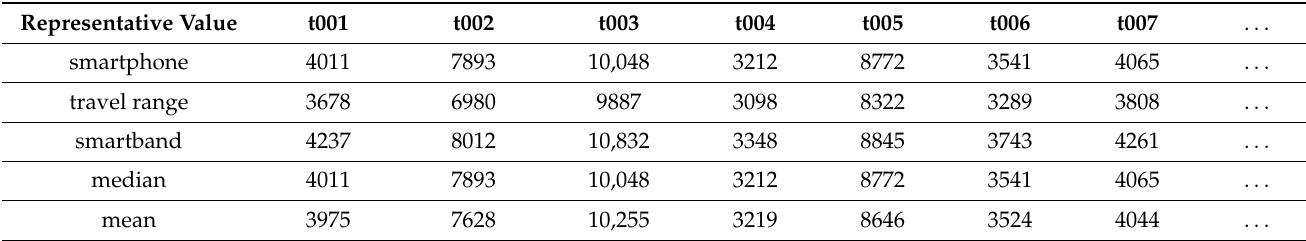
Table 3. Selection of representative values with the uses of the mean, median, and quartile (redun- dancy value of step count is